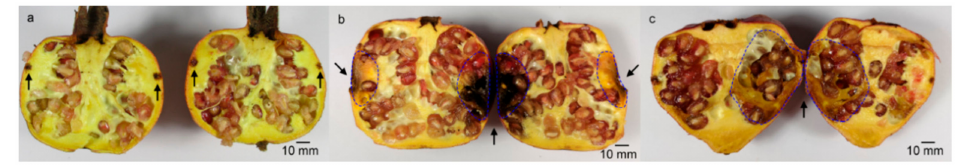
Figure 3. Interior symptoms of the control pomegranate ( a ), the soft rot pomegranate ( b ), and the dry rot pomegranate ( c ) after 10 days of pathogen infection in the chamber (28 ◦ C, 90%